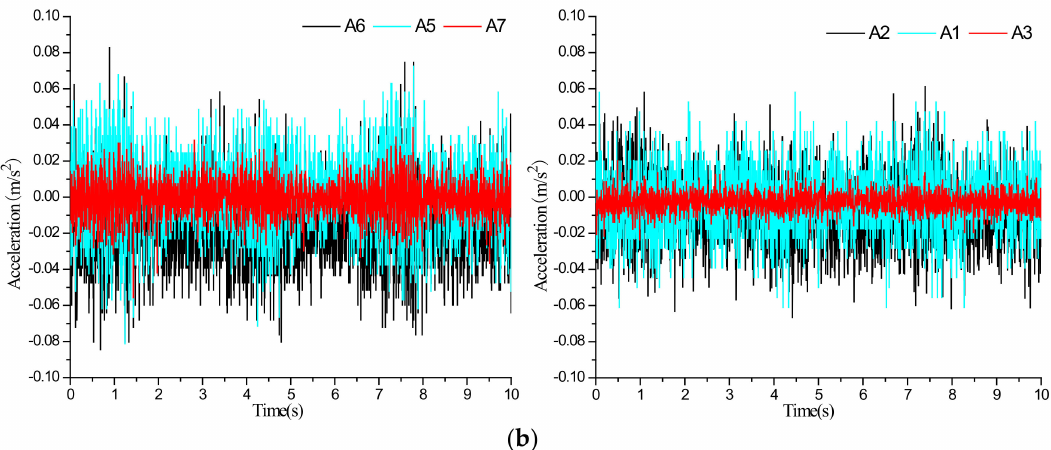
Figure 14. Acceleration time series under the combined impact of hanging wall descending (1 cm) and 10 Hz excitation: ( a ) vibration exciter at 60 cm; ( b ) vibration exciter at 100 cm.